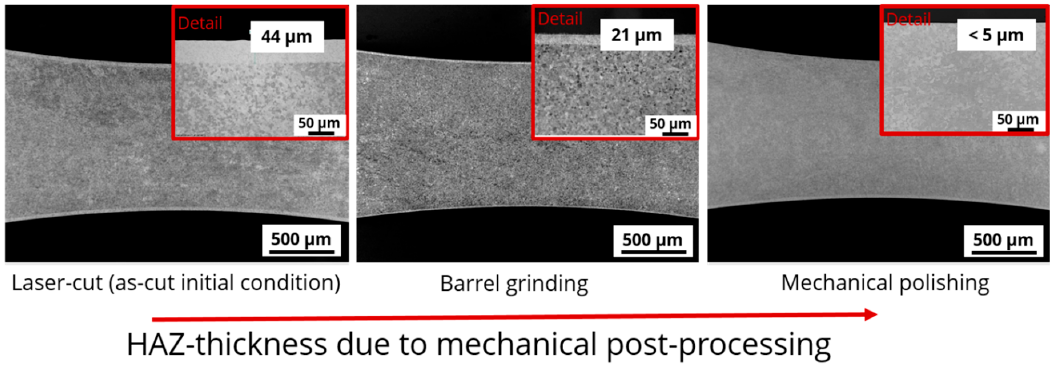
Figure 6. Thickness of the HAZ dependent on the mechanical post-processing showing a significant decrease in measured HAZ-thickness at the upper cutting edge.